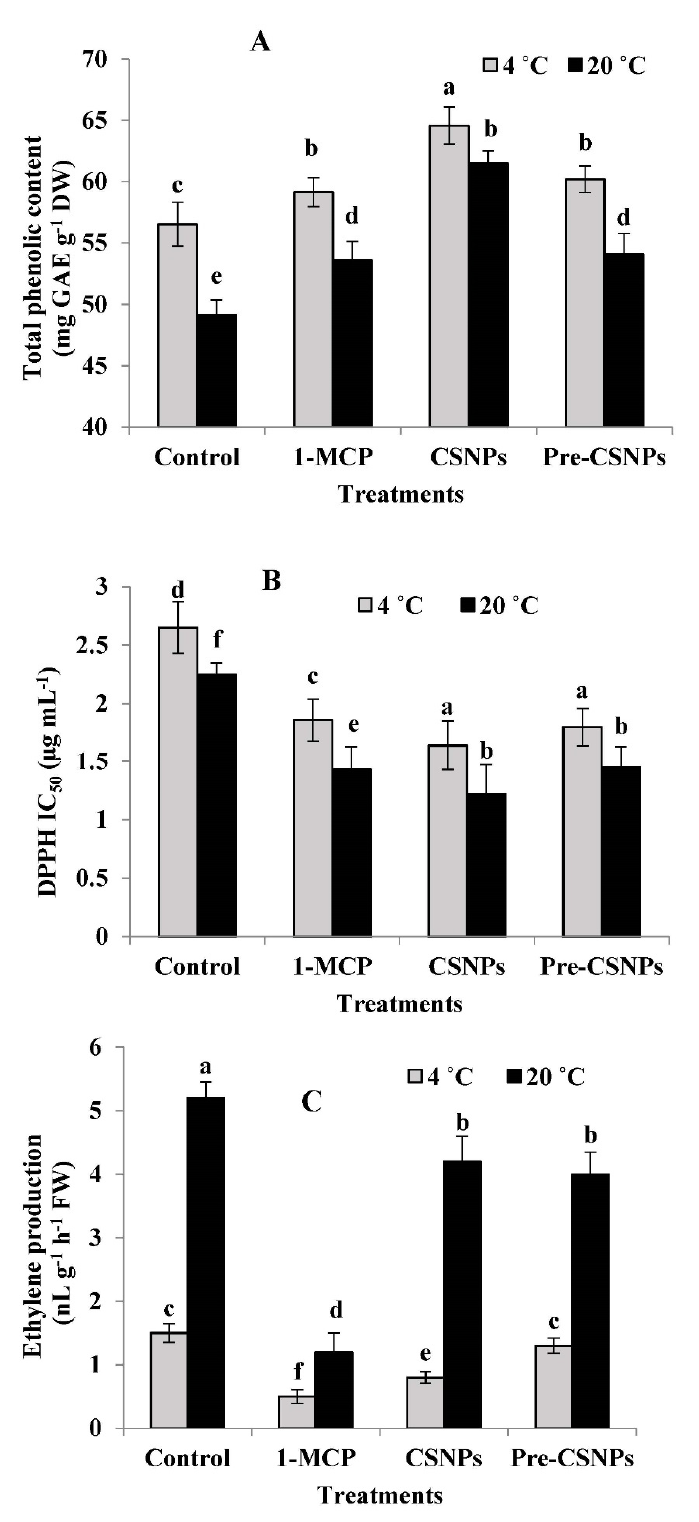
Figure 3. Total phenolics content ( A ), antioxidant activity ( B ) and ethylene production ( C ) of damask rose flowers stored at 4 or 20 °C and treated with 1-MCP and pre- and post-chitosan nanoparticles (CSNPs). Values are the means ± SE of two investigations ( n = 8). Columns with different letters are statistically different at p ≤ 0.05.